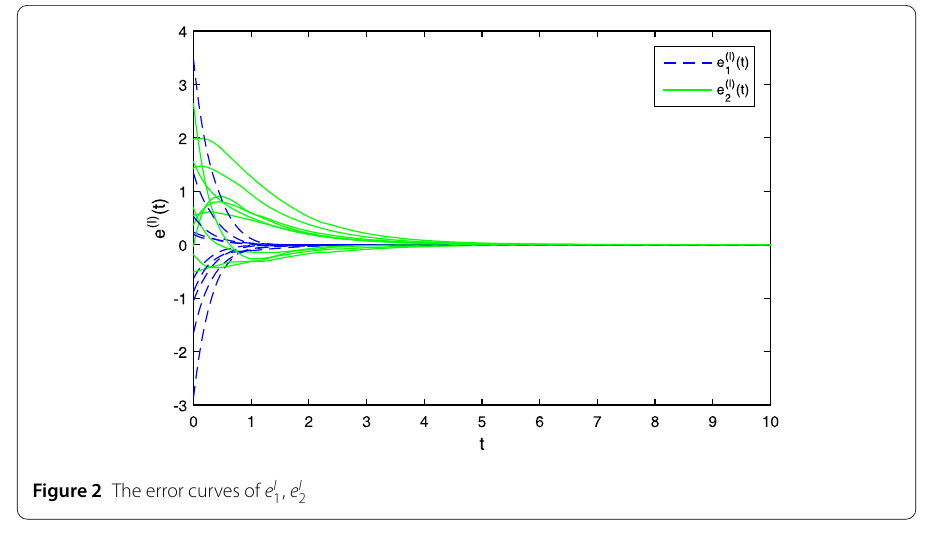
Figure 2 The error curves of e I 1 , e I 2